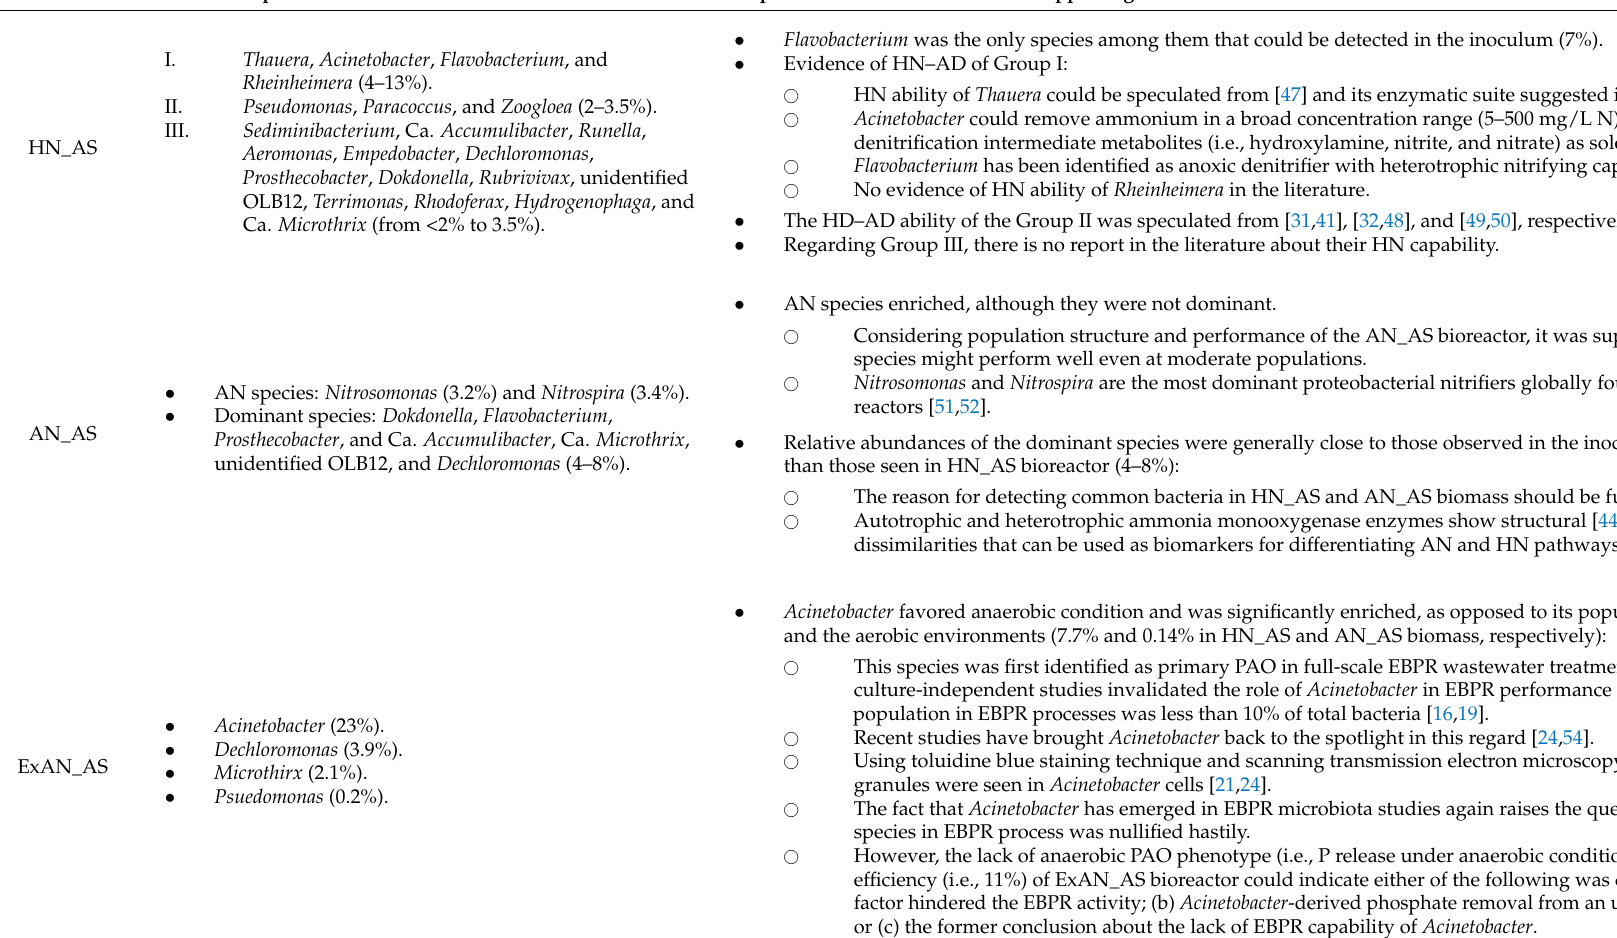
Table 3. Dominant bacterial species under different selection